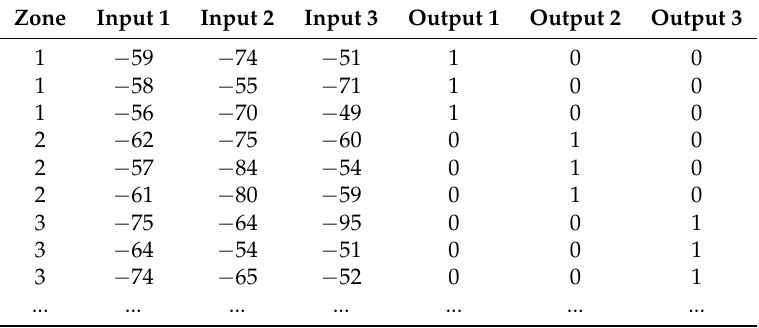
Table 1. Sample of collected data for Scenario